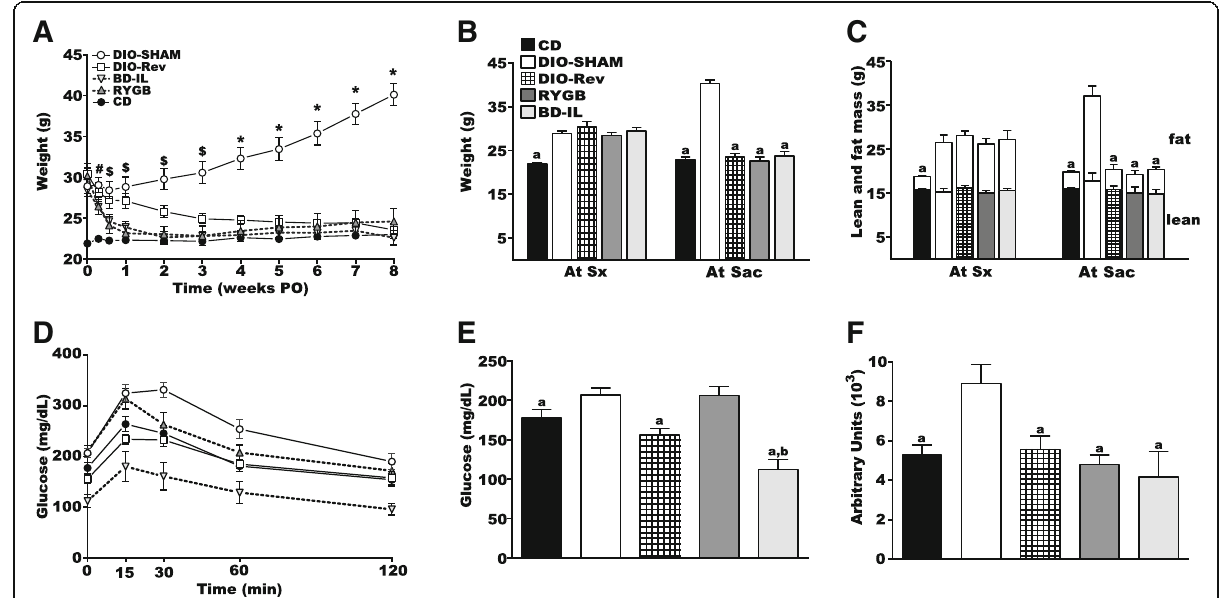
Fig. 2 Bariatric surgery result in normalization of body weight, body composition, and glucose tolerance. a Body weight over time following bariatric surgery or diet-reversal. At the time of surgery (At sx) mice are 18 weeks of age with the weight of all groups statistically different from CD. The weights of both RYGB and BD-IL mice reached similar weights to CD controls approximately 4 days after surgery while DIO-Rev mice did so 4 weeks after diet transition. # p < 0.05 for DIO-SHAM, DIO-Rev, and RYGB versus CD. $ p < 0.05 for DIO-SHAM and DIO-Rev versus CD. * p < 0.05 for DIO-SHAM versus CD. b Body weight of all experimental groups at the time of surgery (At Sx) and sacrifice (At Sac). c Body composition of all experimental groups at the time of surgery (At Sx) and sacrifice (At Sac). d Blood glucose levels in surgical and control mice during an oral glucose tolerance test. e Fasting blood glucose levels ( f ) Glucose integrated area under the curve (AUC). a=significant difference versus DIO-SHAM. b=significant difference versus CD. p <0.05 ( n =6 – 8 per group). Data are represented as